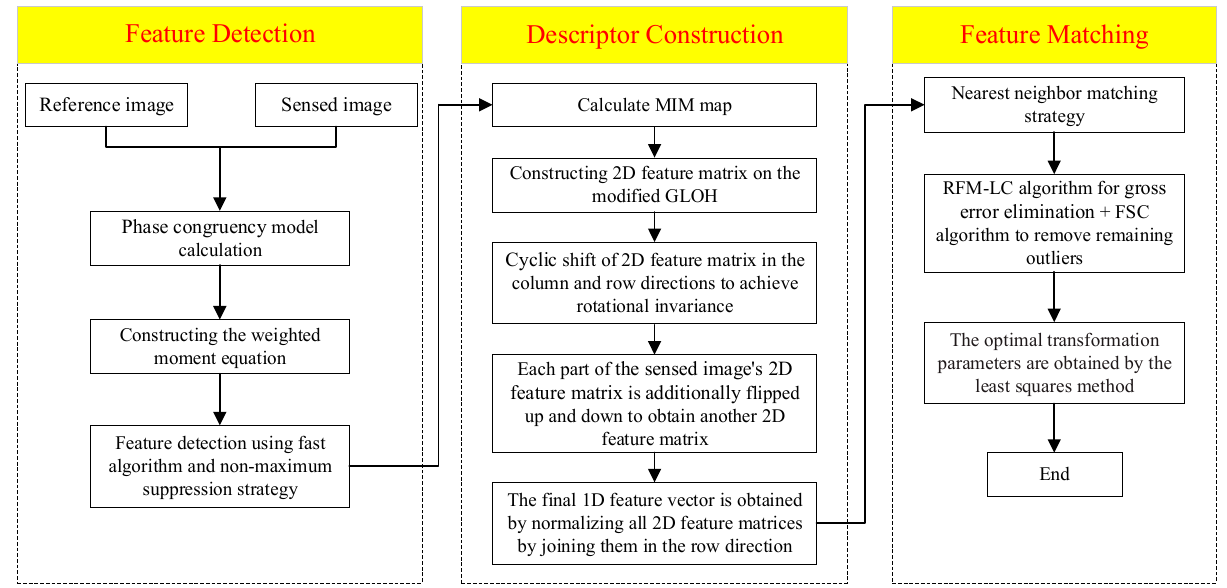
Figure 1. The pipeline of RI-LPOH.